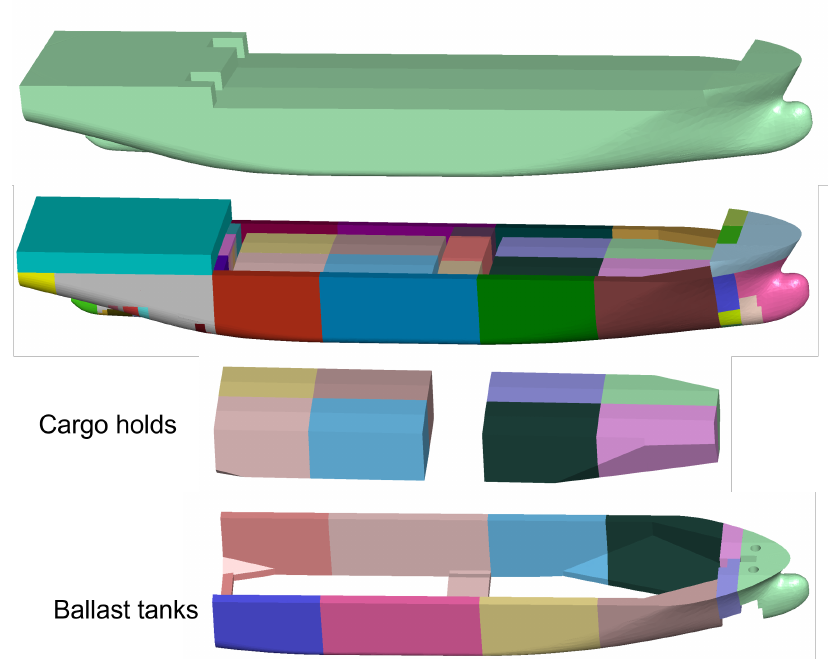
Figure 6. Hull and all holds of the tanker “TAI HUA WAN”.